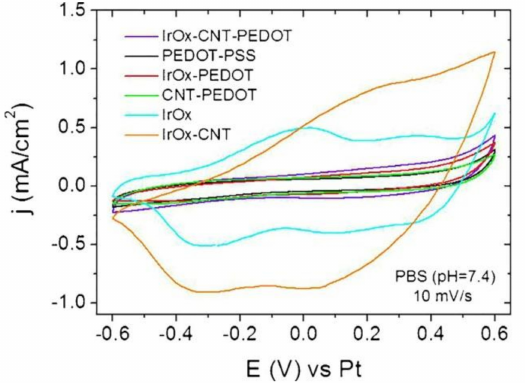
Figure 9. CV showing the significant decrease in current when PEDOT is incorporated to the IrO x -CNT hybrid. (IrO x -CNT compared with IrO x -CNT-PEDOT and with individual components). The lowest currents always correspond to the composites or hybrids containing PEDOT [18]. With permission from